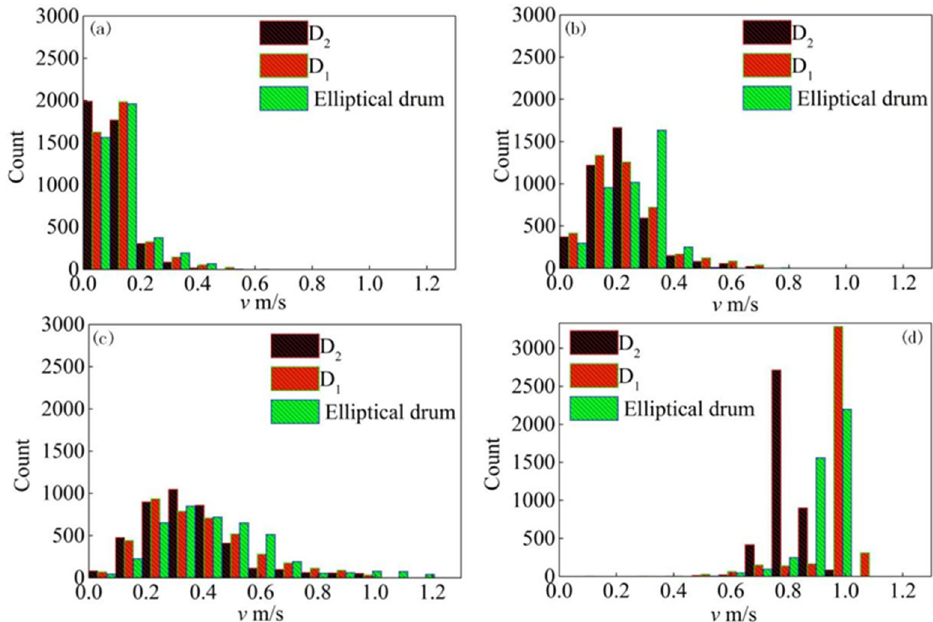
Figure 6. Count of the velocities of the particles at different rotational speeds. ( a ) 3.14 rad/s; ( b ) 8.64 rad/s; ( c ) 15.64 rad/s; ( d ) 21.7 rad/s.